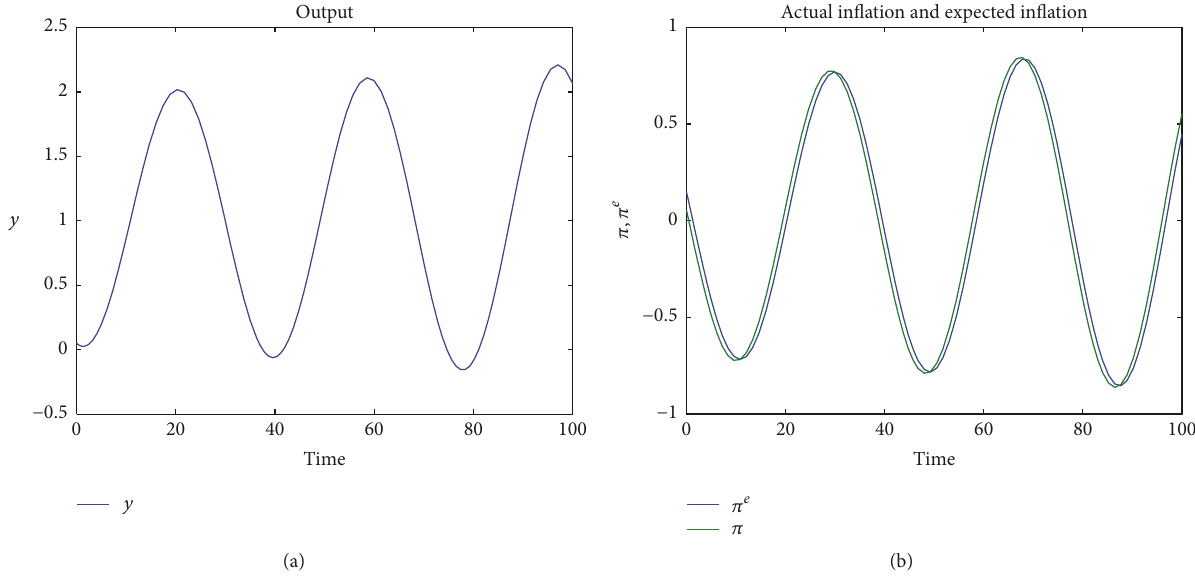
Figure 5: Simulation (3) . (a) Solution for 𝑦(𝑡) . (b) Solutions for 𝜋(𝑡) and 𝜋 𝑒 (𝑡) .